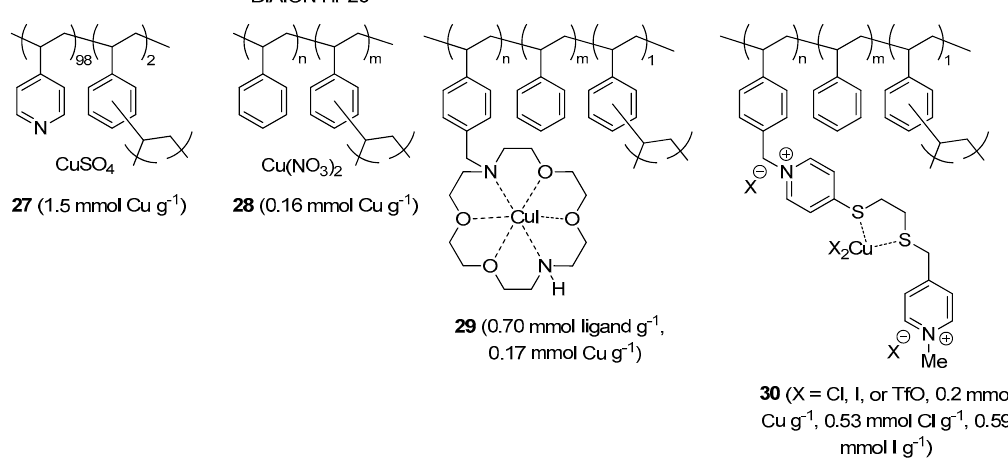
Figure 3. CuAAC catalysts and pre-catalysts 27 – 30 , on insoluble organic supports from commercial